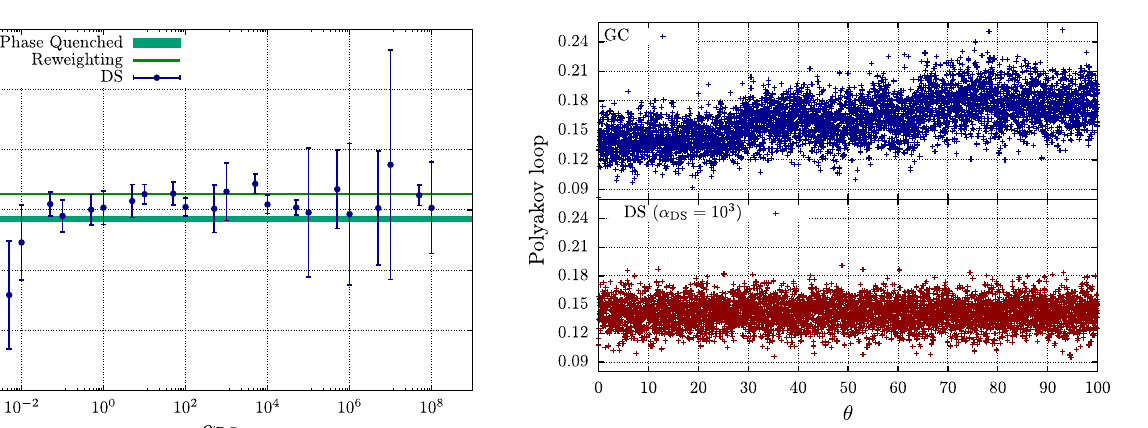
Fig. 3 The average Polyakov loop as a function of α DS compared with the result generated with reweighting for HDQCD in a 10 3 × 4 lattice, with κ = 0 . 04, β = 5 . 8 and μ = 0 . 7. Agreement is found once α DS is sufficiently large